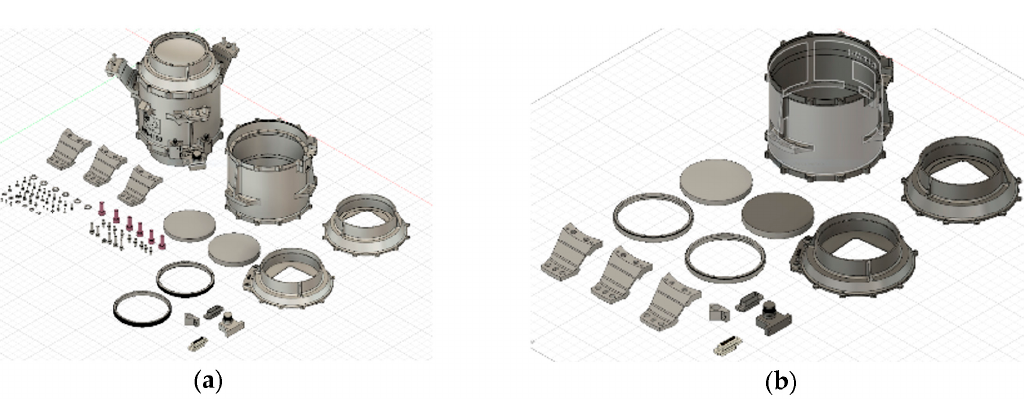
Figure 4. ( a ) Piece without screws in Fusion 360. ( b ) Piece with screws in Fusion 360. ( c ) Piece printed with screws.